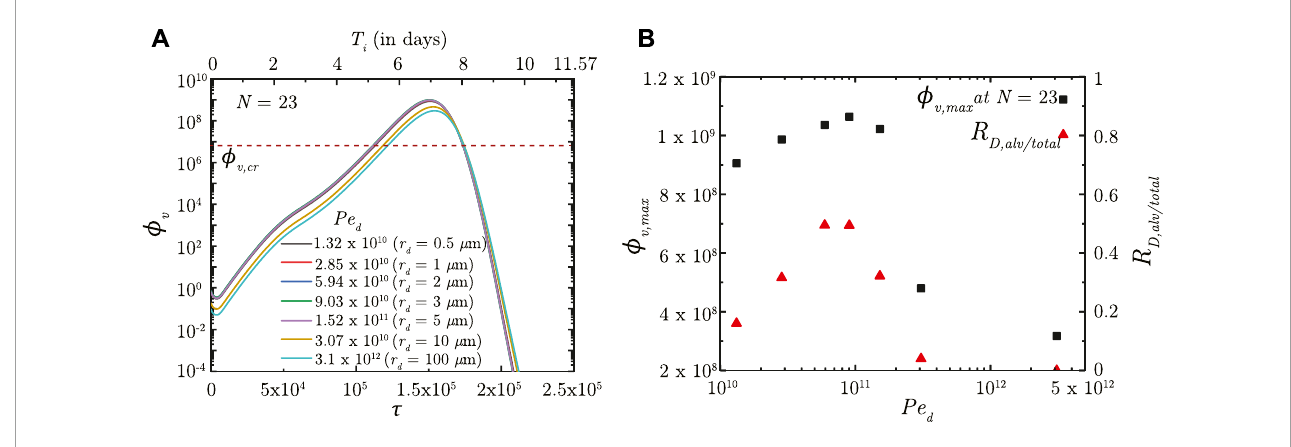
FIGURE 3 (A) Temporal change in dimensionless virus concentration ( ϕ v ) at N = 23 (deep lung) for different Pe d with respect to dimensionless time ( τ ) as well as a dimensional time ( T i ) post infection onset. The breathing time period ( T b = 4s) is considered for obtaining the dimensional time (see Eq. 7 ). Dimensional droplet radii ( r d ) is additionally mentioned for each Pe d considering a tidal volume of 1,000 mL. (B) Change in peak dimensionless virus concentration ( ϕ v ,max ) in the deep lung with varying Pe d (10 10 − 5 × 10 12 ; r d = . 4 − 160 μ m). Results indicate that ϕ v ,max in the deep lung follows a similar trend as the ratio of deep lung (alveolar) deposition to total droplet deposition in the lungs ( R D , alv / total ) . The dotted line indicates the critical viral load ( ϕ v , cr ) in the deep lung required for pneumonia onset (Fajnzylber et al., 2020; Wölfel et al., 2020).